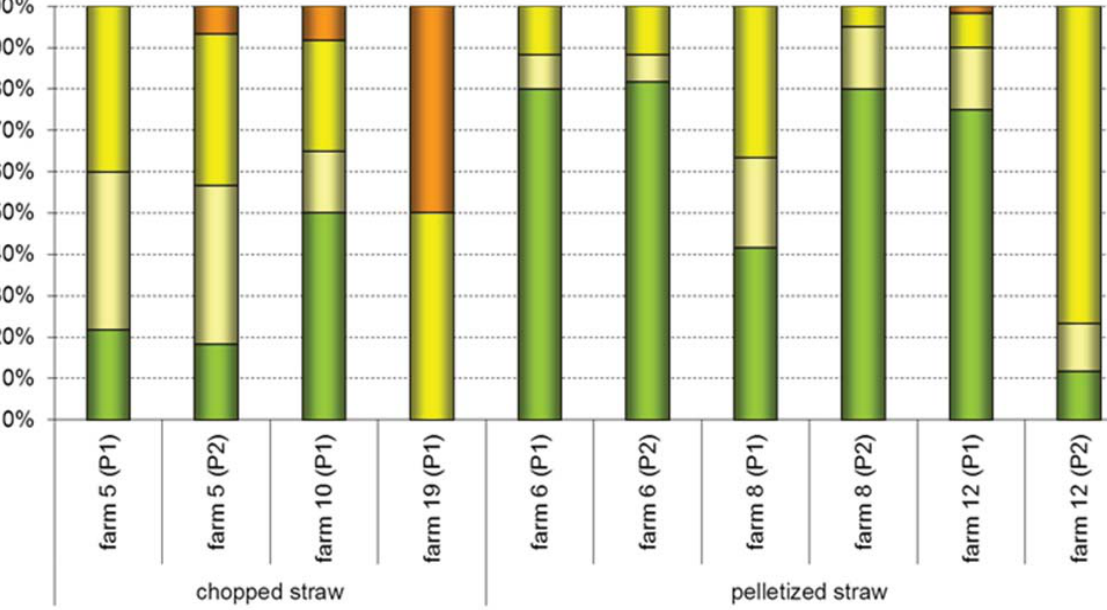
Figure 6. Differences in the prevalence of foot pad alterations by usage of chopped straw and pelletized straw, respectively, during Day 22 to 35. P: observed rearing